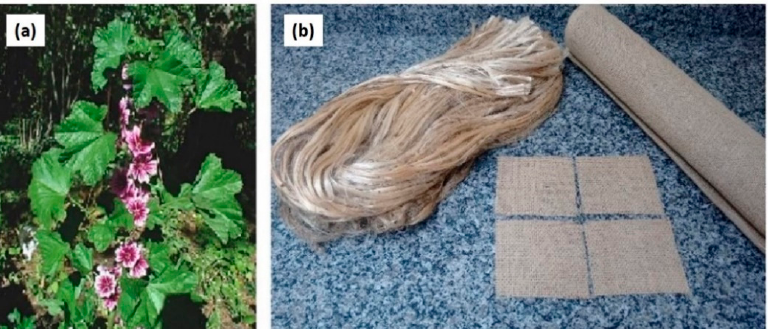
Figure 22. ( a ) Mallow plant; ( b ) mallow fiber, hybrid and pure fabric used to be incorporated in epoxy composites. (Adapted with copyright permission from Nascimento et al. [148]).